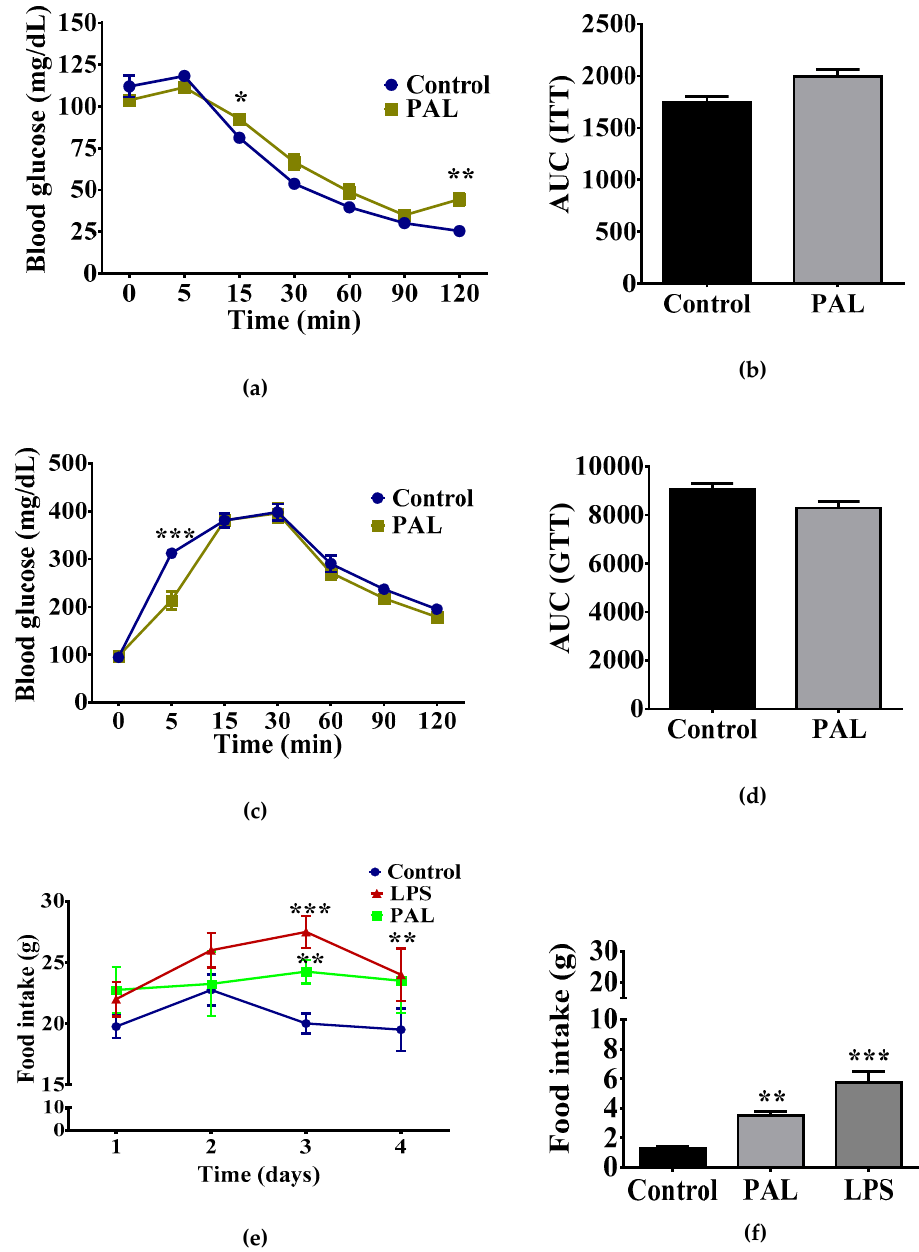
Figure 4. Chronic i.c.v. palmitic acid administration sensitizes ghrelin signaling leading to food intake increase. ITT and area under the curve (AUC) ( a – b ) and GTT and AUC ( c – d ) were analyzed following i.c.v of 2 μ g/mL LPS or 40 μ g/ μ L palmitic acid administration for five days. Daily food intake quantification following palmitic acid, LPS or ACSF administration ( e ). Ghrelin-sensitive food intake was analyzed by day 5 after 2 h, 1 μ g/ μ L ghrelin i.c.v. administration ( f ). The graphs show normalized